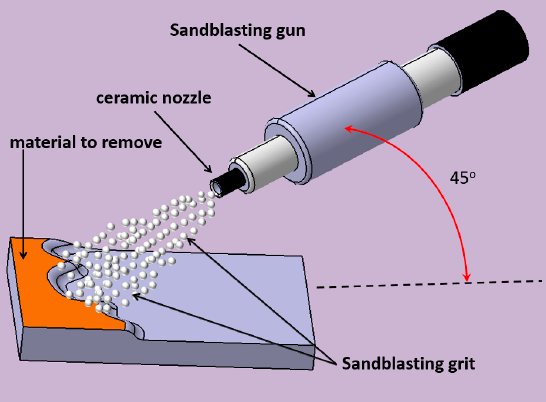
Figure 1. Schematic drawing of the sandblasting process used for S235JR steel samples.